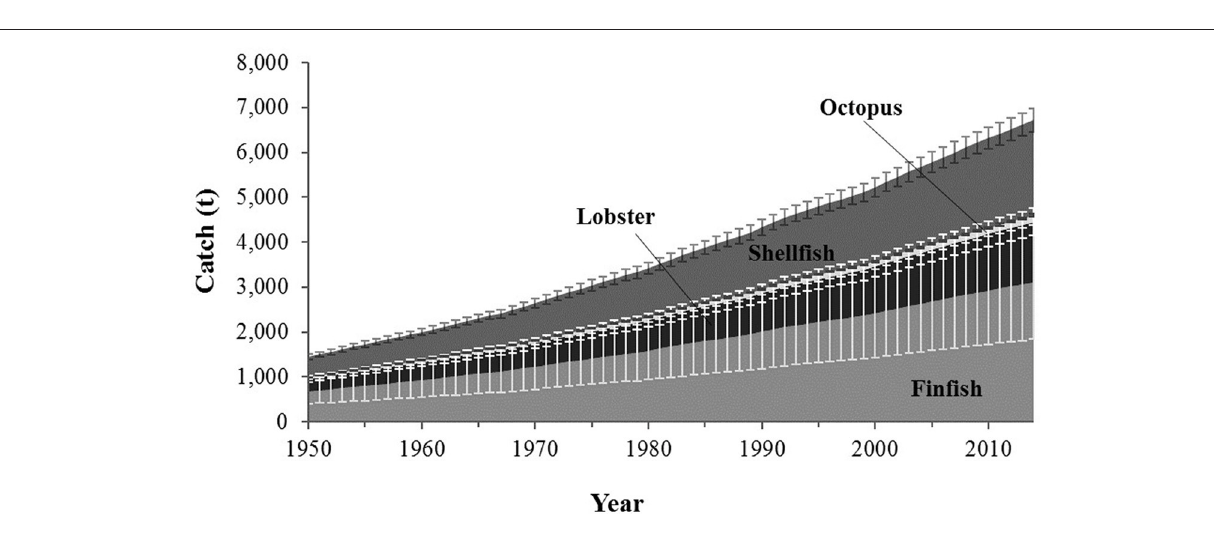
FIGURE 6 | Total reconstructed shallow water catches not for export (i.e., subsistence and local artisanal) in Vanuatu, 1950–2014 by major taxonomic groups. 95% confidence intervals of estimates are